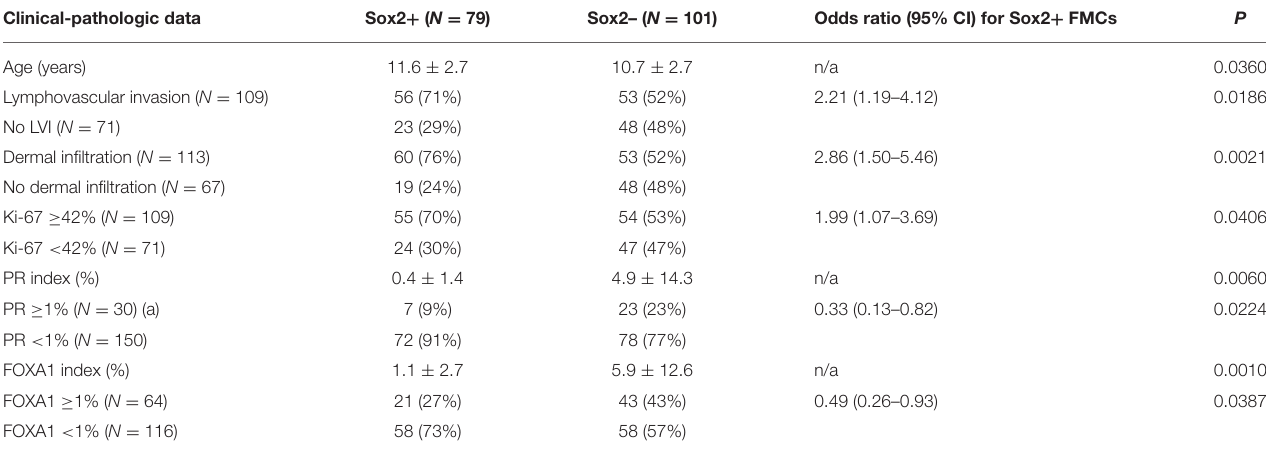
TABLE 1 | Clinical-pathologic associations with Sox2 expression evaluated at > 42% cutoff in feline mammary carcinomas ( N = 180). Clinical-pathologic data